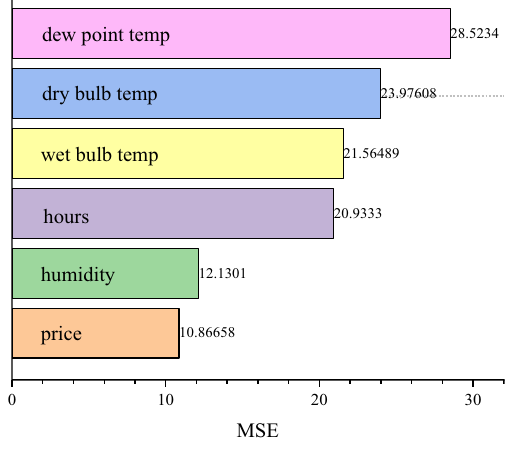
Fig. 5 The rank of the importance of the multivariate features. The value of the horizontal axis represents the decrease of the accuracy of the model after this variable was removed. The greater the decrease, the greater the contribution of which variable for the model predic- tion